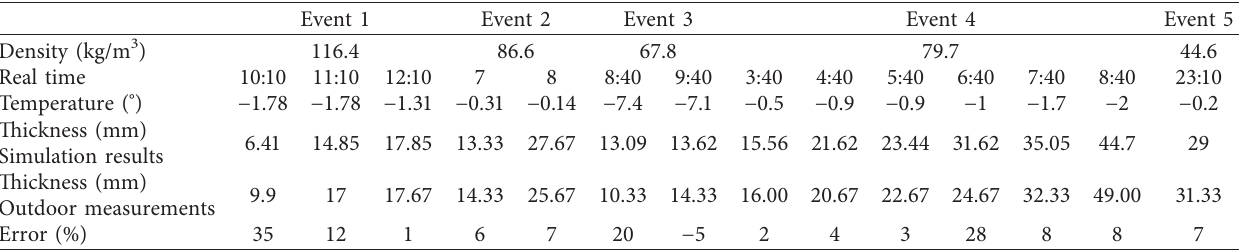
Table 2: Comparison of the maximum snow thickness obtained from the experiments and simulations for different